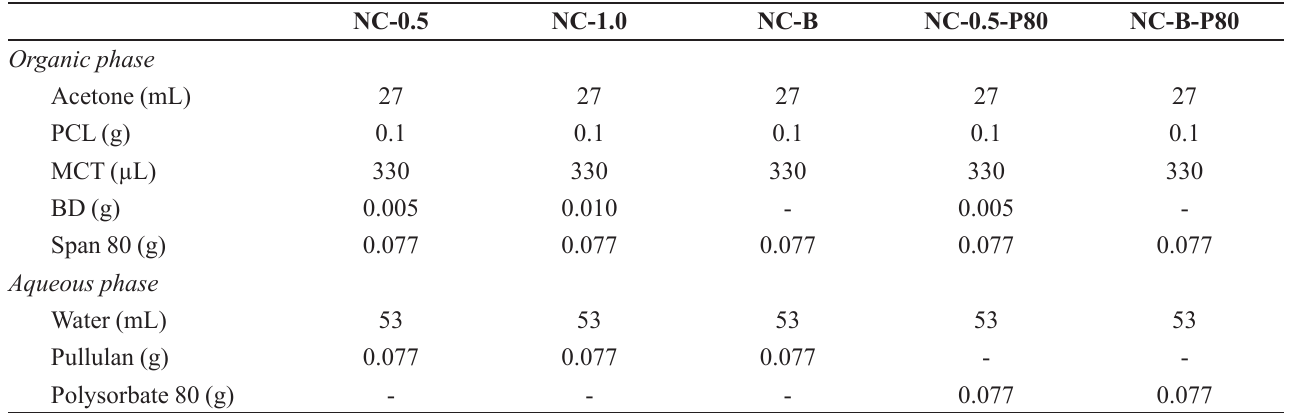
TABLE I - Quali- and quantitative composition of nanocapsule